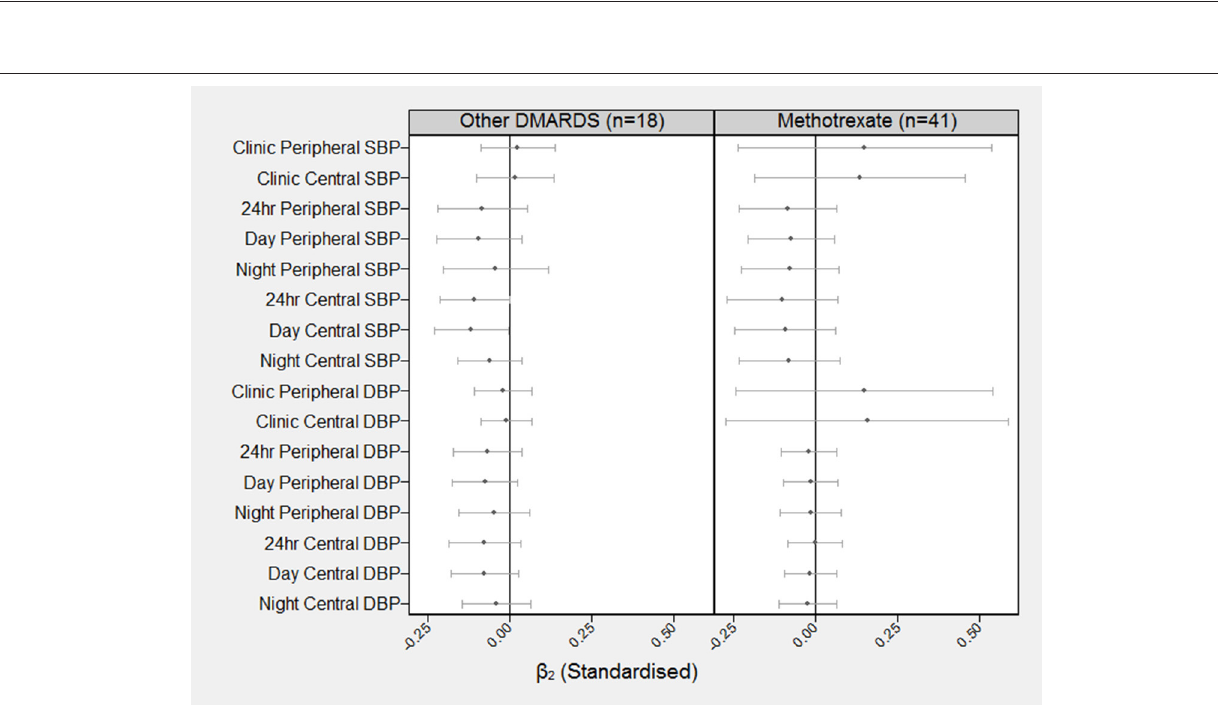
Frontiers in Physiology | www.frontiersin.org